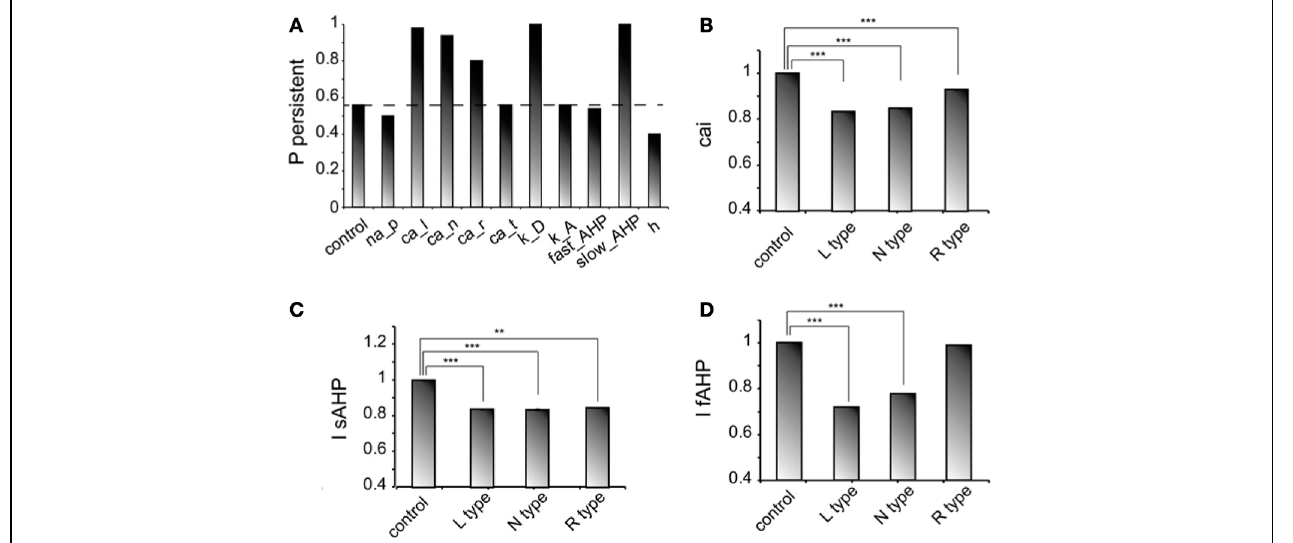
FIGURE 4 | Intrinsic conductances modulate persistent activity induction. (A) Bar graph showing the effect on induction probability when the conductance of the various currents is reduced to 10% of its control value (iNMDA-to-iAMPA = 2.3, iGABA B -to-iGABA A ratio = 0.4, dADP deactivated). (B) Bar graph showing the normalized change in intracellular calcium concentration (measured as the integral over the inducing stimulus period) with respect to the control value when L, N or R type calcium channels are